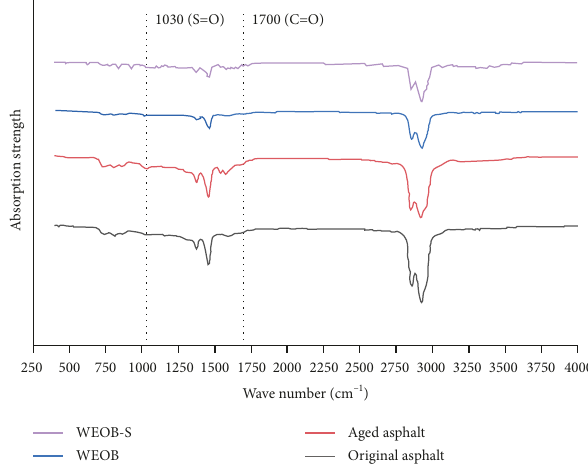
Figure 3: Infrared spectra of asphalt before and after aging and